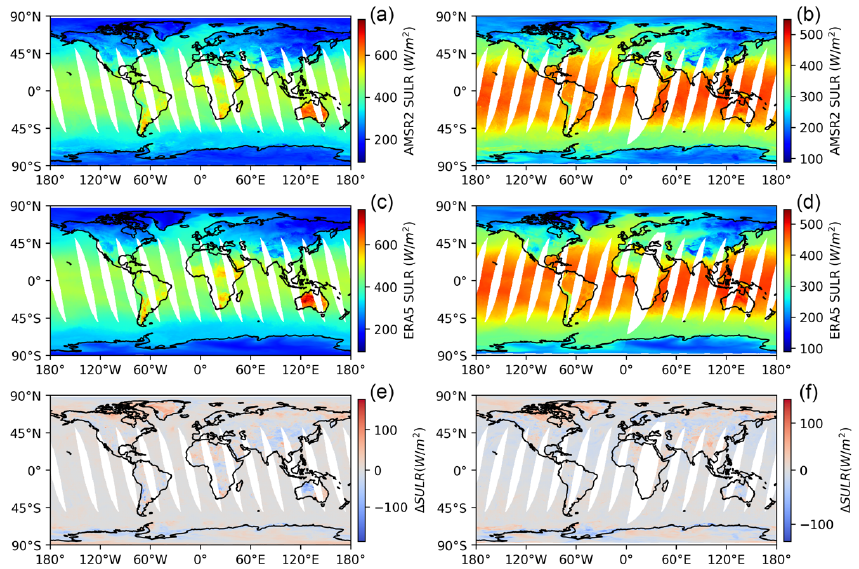
Figure 6. Comparison of the global Advanced Microwave Scanning Radiometer 2 (AMSR2) and European Centre for Medium-Range Weather Forecasts (ECMWF) Reanalysis v5 (ERA5) surface upward longwave radiation (SULR) data from 1 January 2020. ( a ) AMSR2 SULR derived from ascending data; ( b ) AMSR2 SULR derived from descending data; ( c ) ERA5 SULR matched with ascending data; ( d ) ERA5 SULR matched with descending data; ( e ) difference between AMSR2 and ERA5 SULR for ascending data; and ( f ) difference between AMSR2 and ERA5 SULR for descending data.